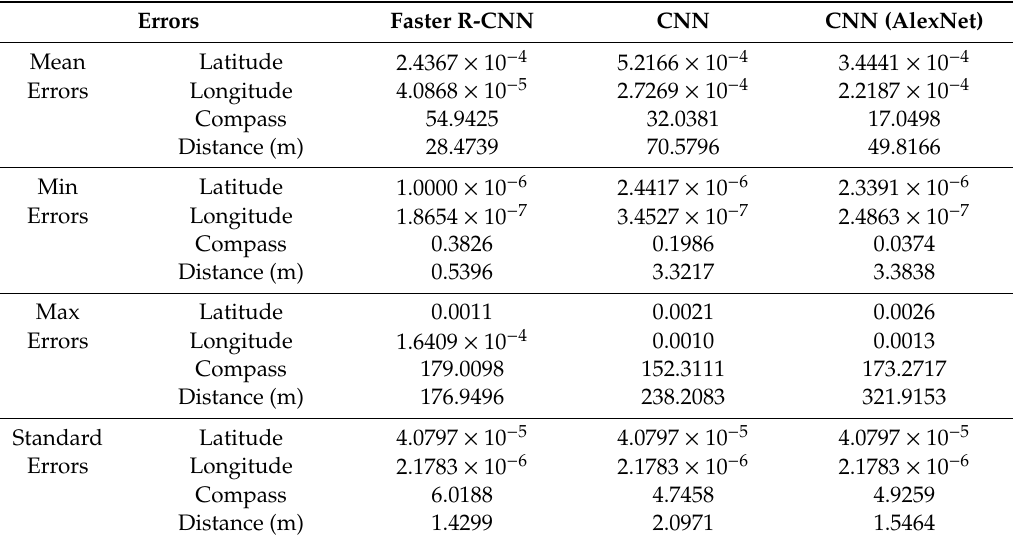
Table 2. Localization errors of proposed